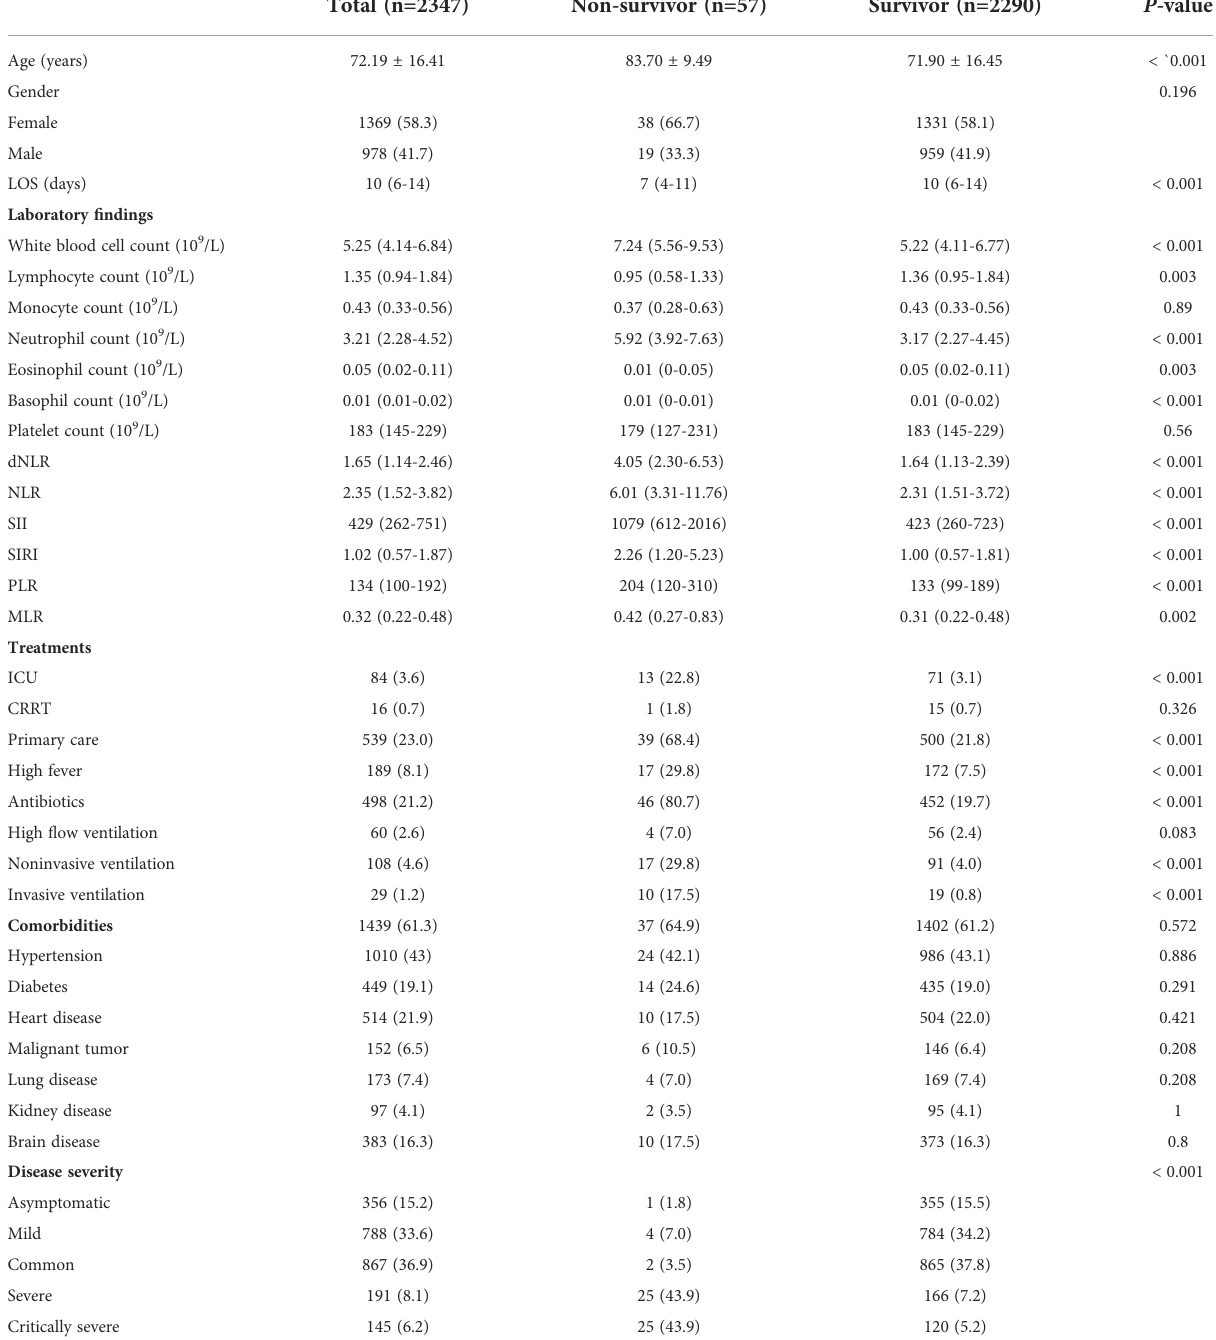
TABLE 1 Demographics and clinical